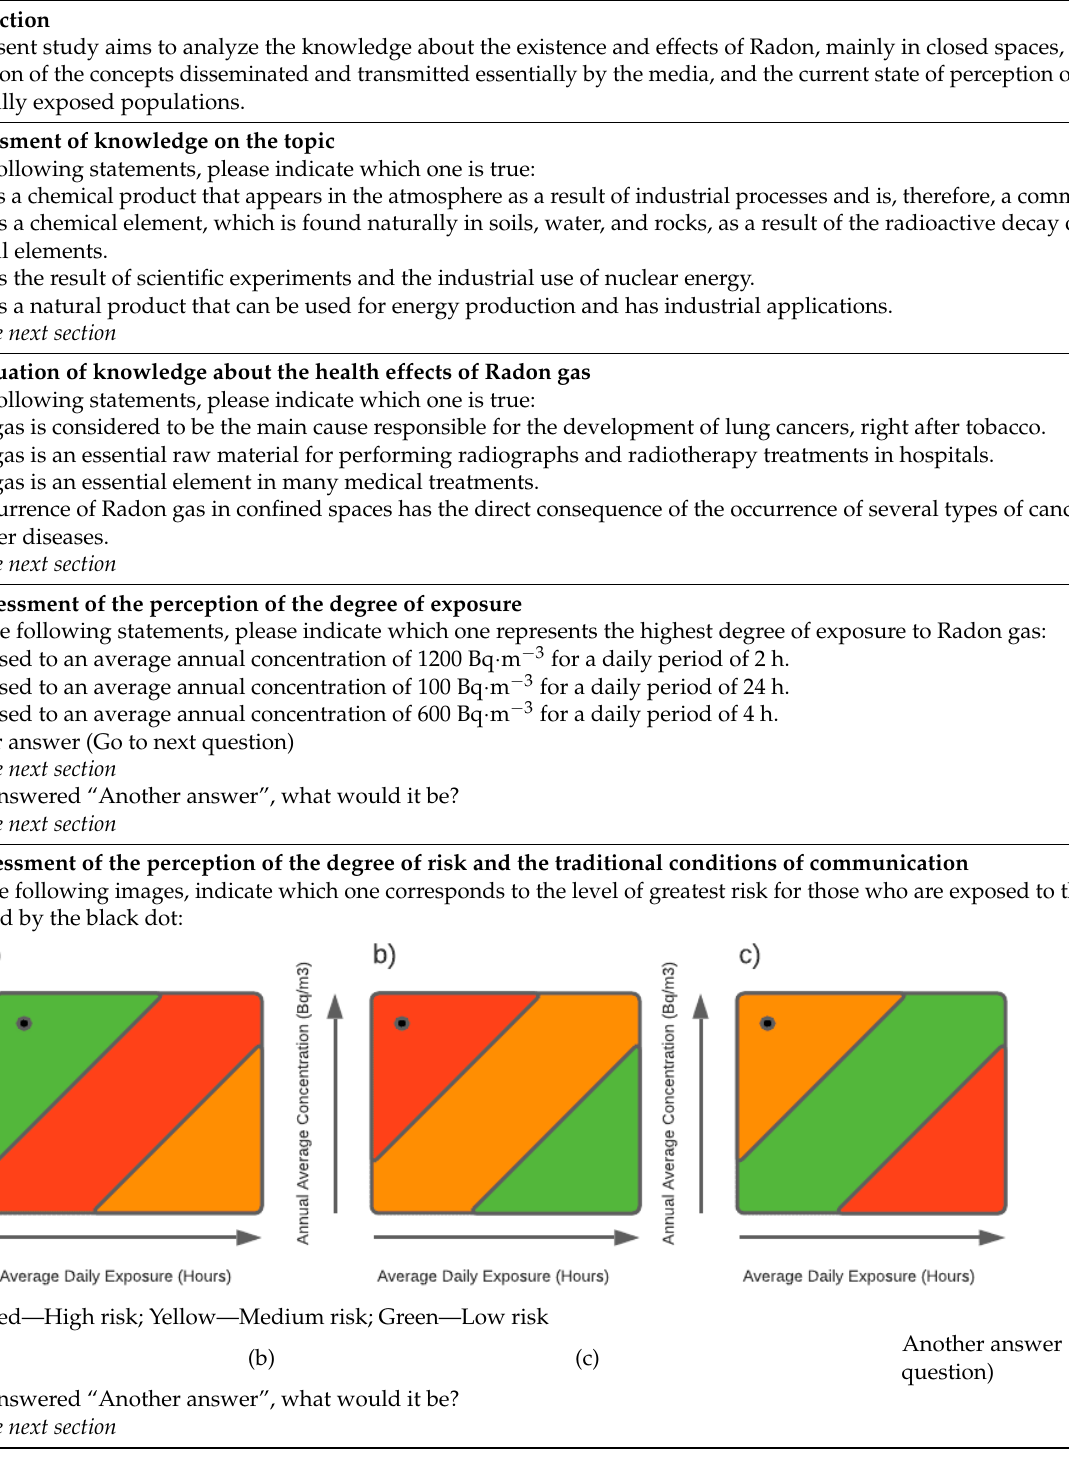
Table 1. Survey presented through GOOGLE FORMS to assess the perception of risk associated with exposure to Radon. Eliminatory Question Have you heard of Radon?